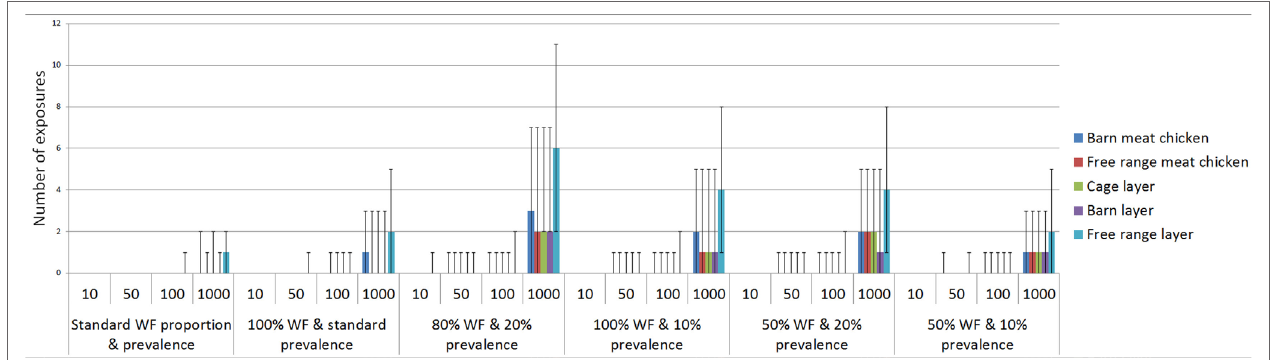
FigUre 4 | Number of low pathogenic avian influenza (LPAI) virus exposures that would occur given a number of wild birds ( n ) and changes in the overall probability of LPAI exposure ( p ) with changes in the proportion of wild birds on the farm that are waterfowl and the prevalence of LPAI in waterfowl for the commercial